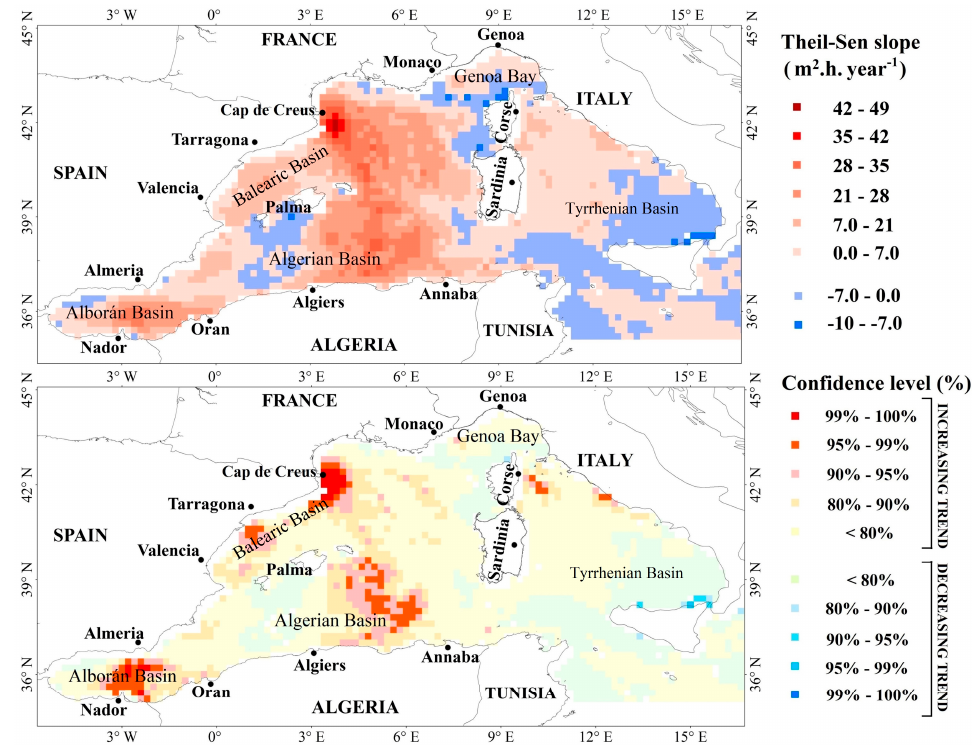
Figure 7. Spatial distribution of long-term trends (Theil–Sen slope in m²·h. year − 1 ) of the annual maxima of the Storm Power Index ( SPI ) ( upper panel ) and their significant trends according to the Mann–Kendall test at different confidence levels ( lower panel ).